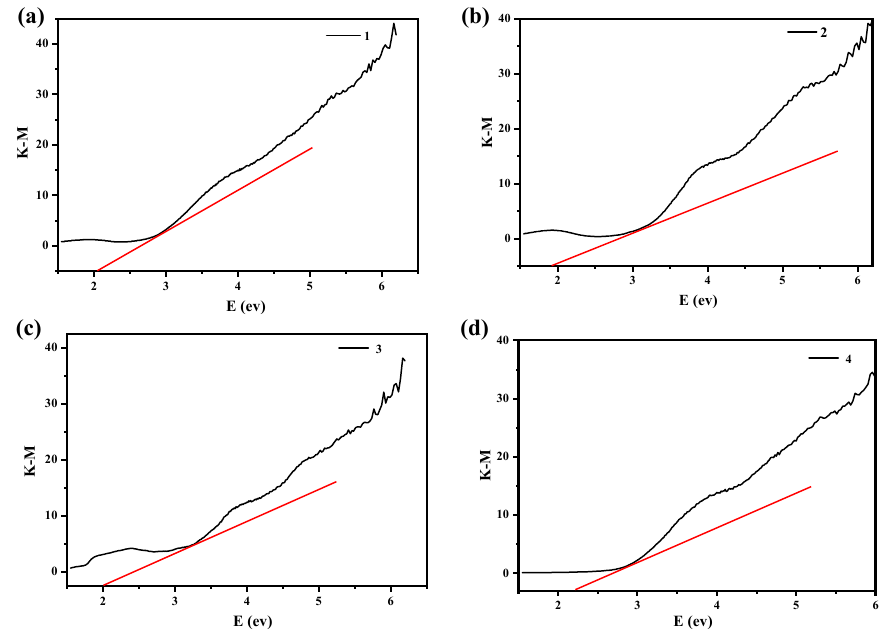
Figure 5. Optical band gap of compounds 1(a) , 2(b) , 3(c) , and 4(d) .